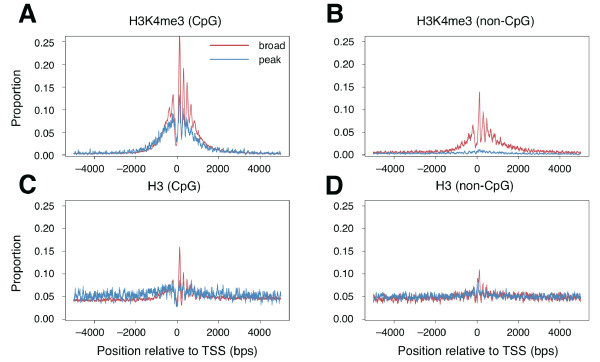
Distributions of nucleosomes around transcription start sites (TSSs) with and without CpG islands. Distributions of nucleosomes containing H3K4me3 (A, B) and H3 (C, D) around broad and peak promoters are shown. The analyses were conducted separately for TSSs that were associated with CpG islands (A, C) and those that were not (B, D). Broad promoters had aligned patterns of nucleosomes containing H3 and H3K4me3, regardless of the existence of CpG islands, and were enriched in H3K4me3. In contrast, peak promoters had little alignment of the H3 pattern, regardless of the presence of CpG islands. The proportion of nucleosomes containing H3K4me3 associated with peak promoters was lower than that associated with broad promoters, particularly in the absence of CpG islands.